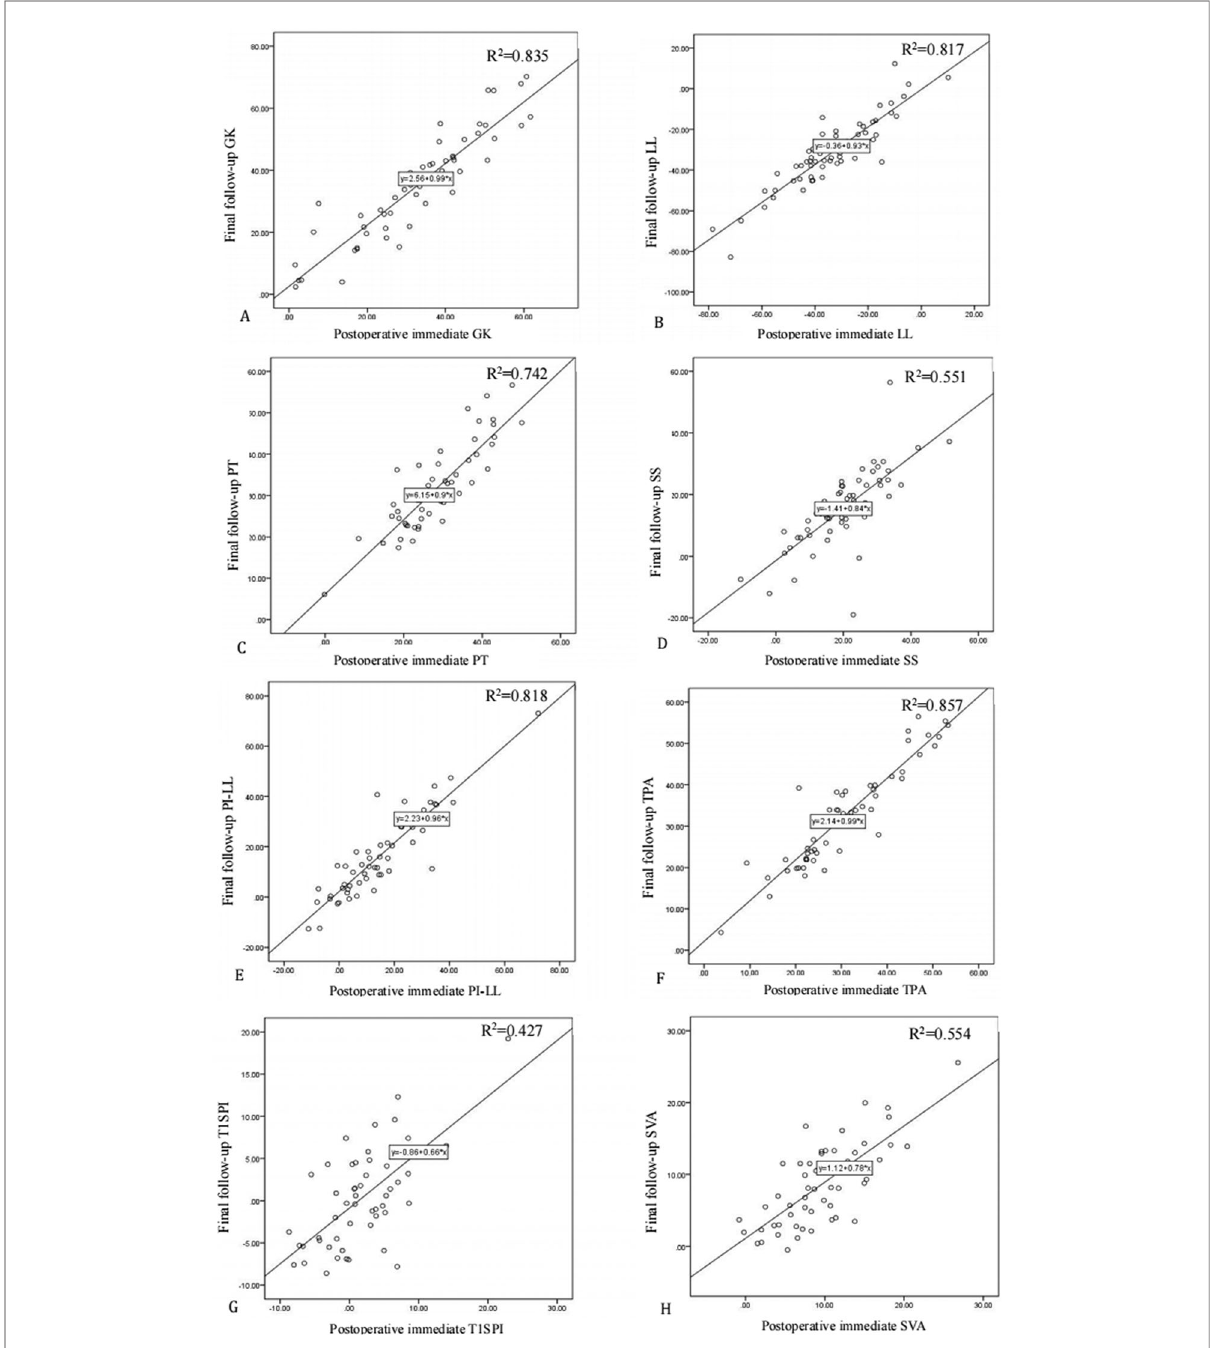
FIGURE 2 Linear regression analysis of postoperative immediate parameters and fi nal follow-up parameters. ( A ) Final follow-up global kyphosis (GK)=2.56+ 0.99×postoperative immediate GK, R 2 =0.835; ( B ) fi nal follow-up lumbar lordosis (LL)= − 0.36+0.93×postoperative immediate LL, R 2 =0.817; ( C ) fi nal follow-up pelvic tilt (PT)=6.15+0.9×postoperative immediate PT, R 2 =0.742; ( D ) fi nal follow-up sacral slope (SS)= − 1.41+0.84× postoperative immediate SS, R 2 =0.551; ( E ) fi nal follow-up pelvic incidence and lumbar lordosis mismatch (PI –